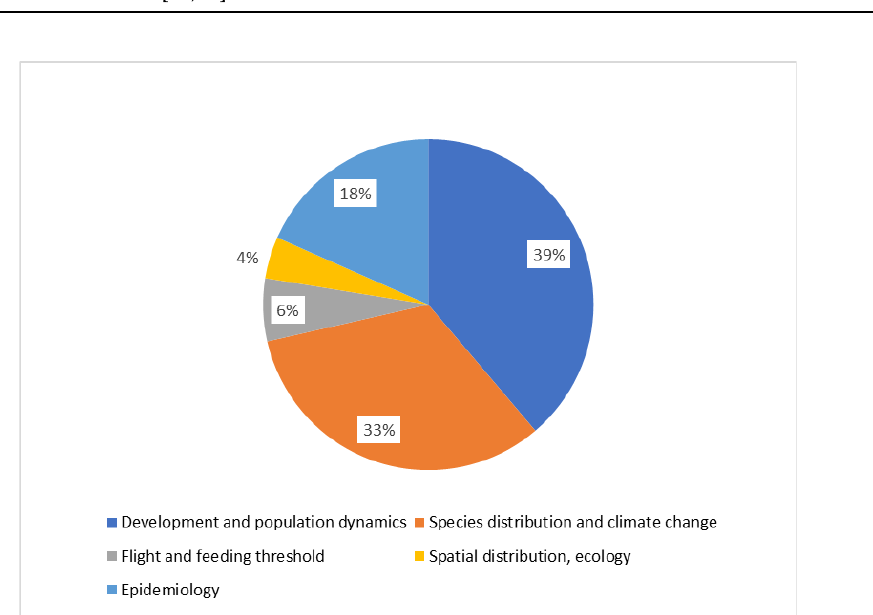
Figure 1. Distribution of published models investigating different life aspects of grapevine pests.